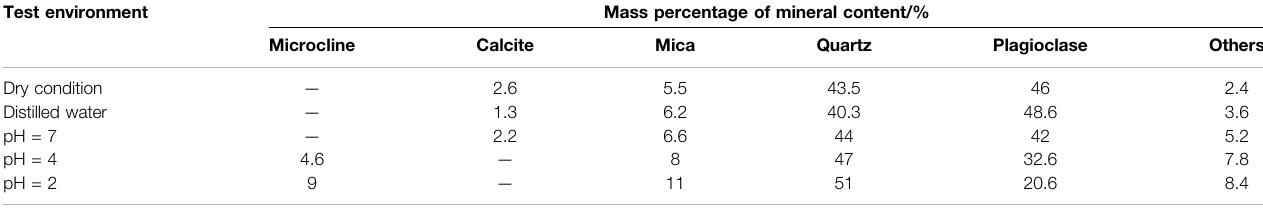
TABLE 3 | Content of main mineral components of granite before and after immersion in different aqueous chemical solutions. Test environment